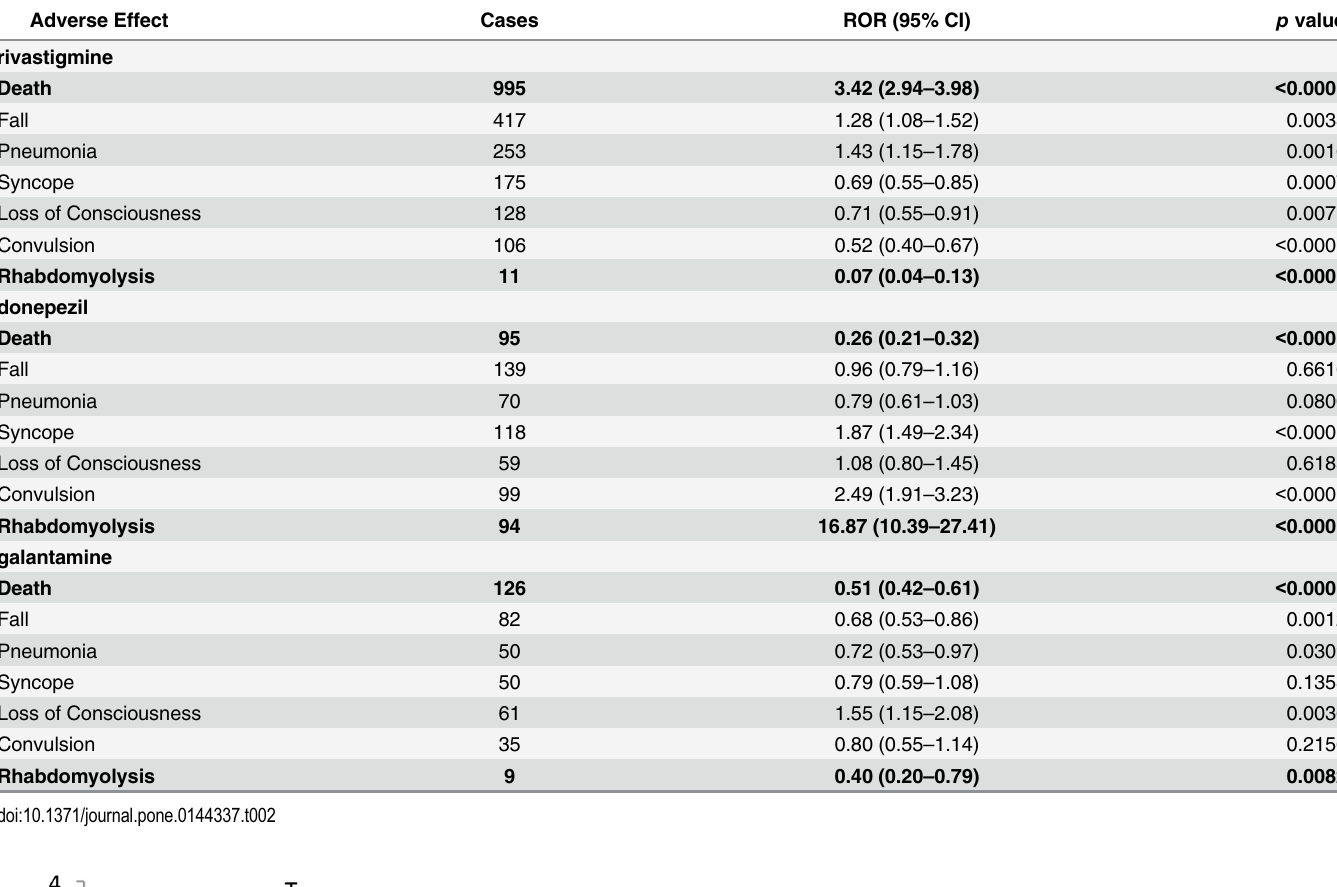
Table 2. FAERS database analysis of reported serious adverse effect.